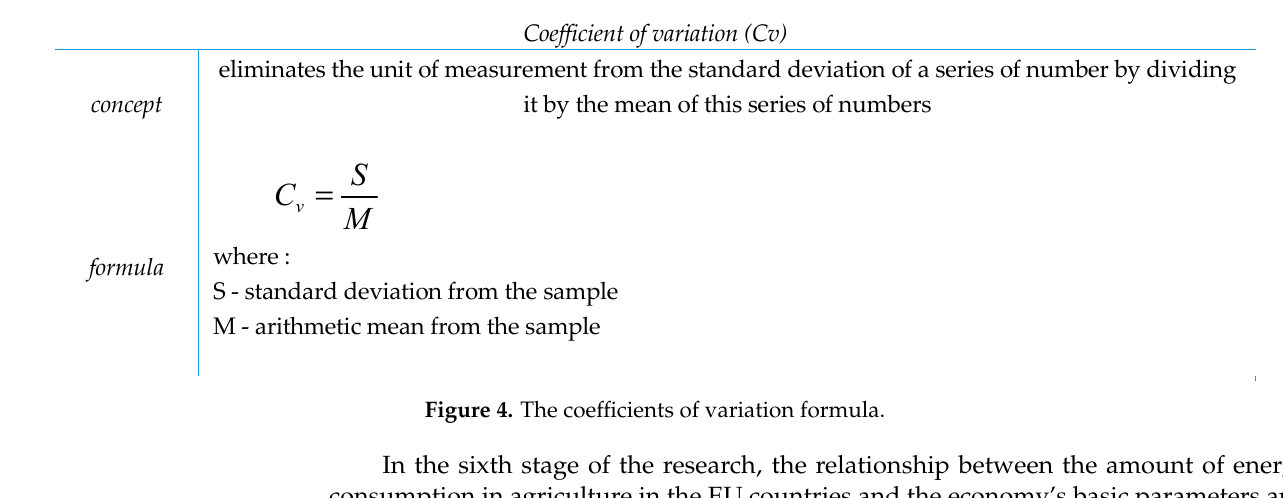
Figure 4. The coefficients of variation Figure 4 . The coefficients of variation formula .